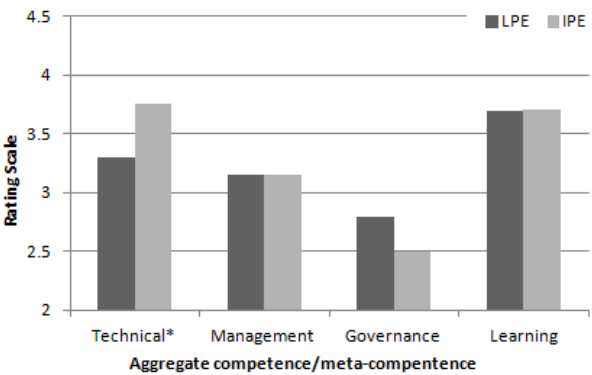
Fig. 4. Aggregate competences and learning meta-competence per- ceived to be acquired during local post-graduate education and in- ternational post-graduate education; rating scale from 1 to 5, where 1=not at all, 3=to some extent, and